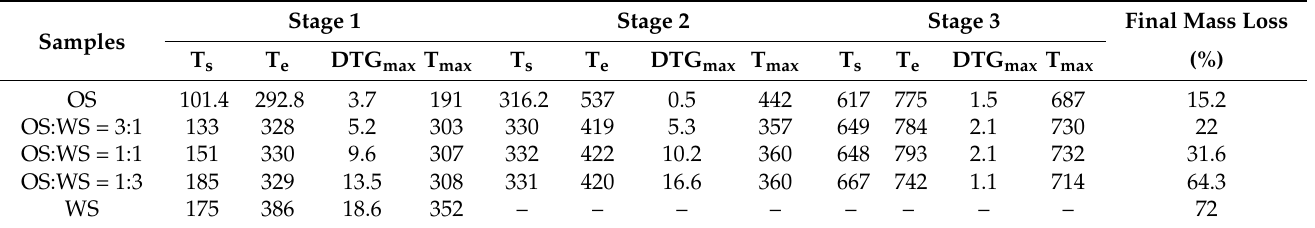
Figure 4. TG curve ( a ) and DTG curve ( b ) of oil sludge and walnut shell at different mixing ratios. Table 3. The main thermogravimetric parameters of different mixing ratios of oil sludge and walnut